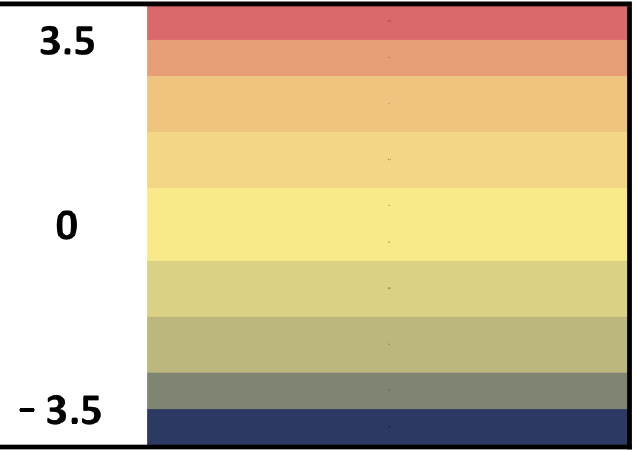
Figure 2. Legend of the color-coding of Figures 1, 3 and 4. Negative values (black color-coding) indicate a relative reduction of the Ct value and thus increased gene expression. Positive values (red color-coding) indicate a relative increase in Ct values and thus reduced gene expression.